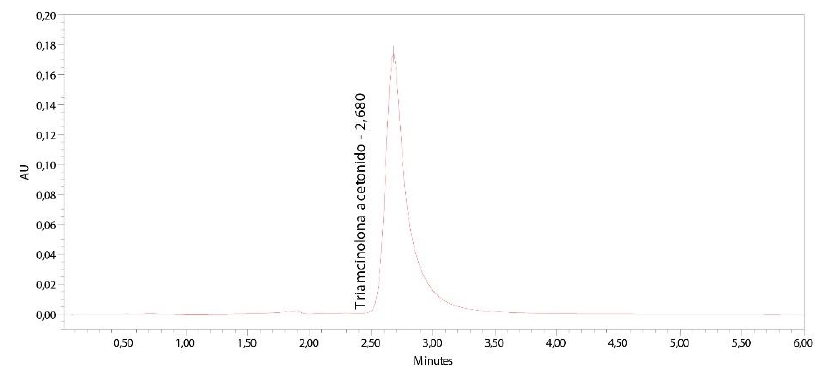
Figure 1. Chromatogram of the TA standard solution.